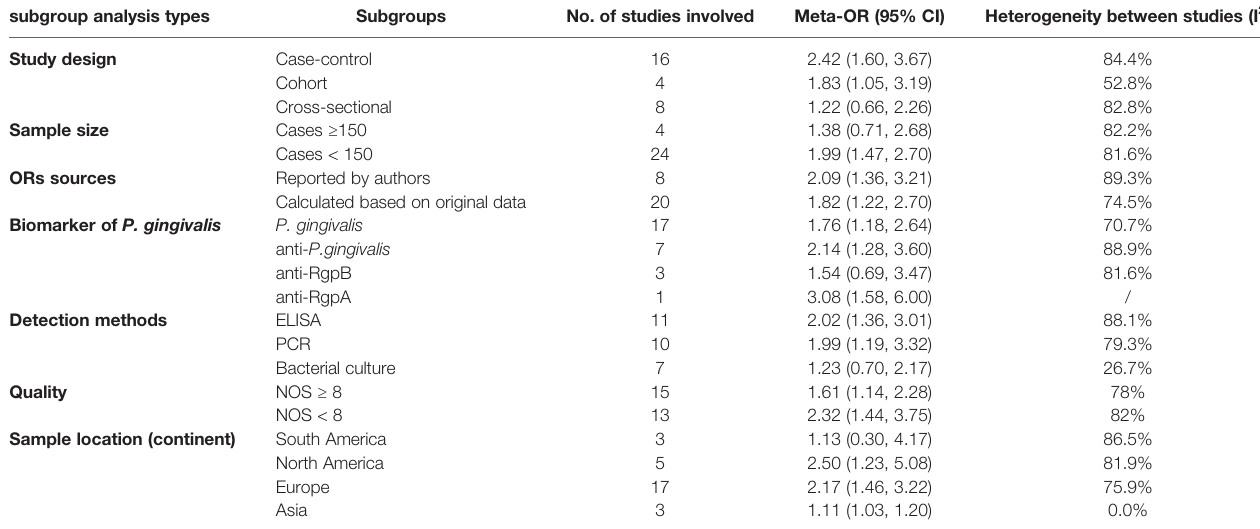
TABLE 2 | Results of subgroups analysis.